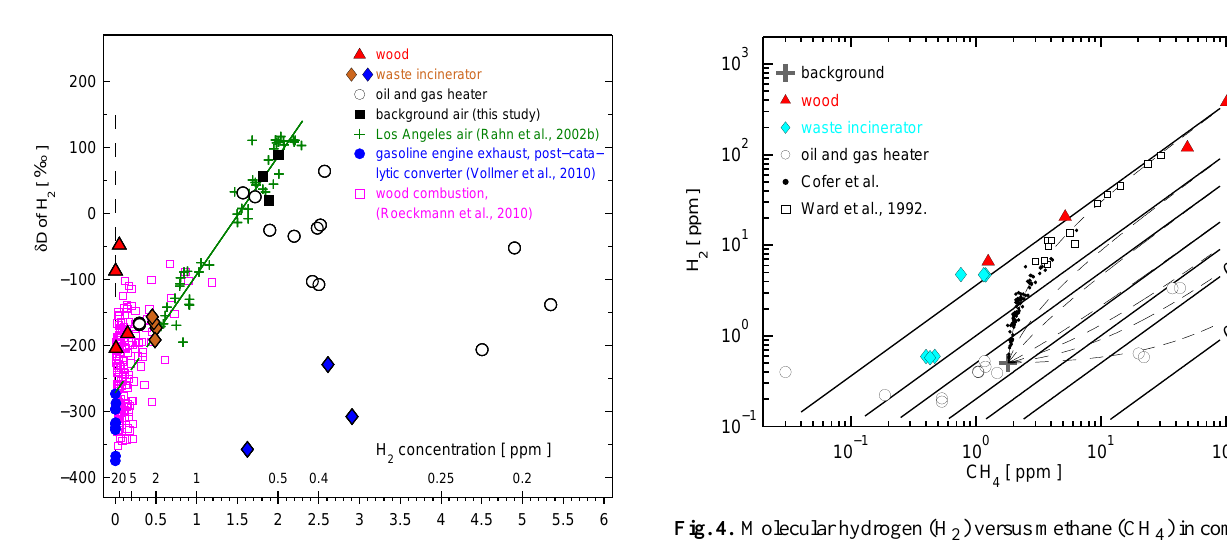
Fig. 4. Molecular hydrogen (H 2 ) versus methane (CH 4 ) in combus- tion exhaust. The measurements are shown on a log-log scale. Re- sults from wildfires are from Cofer III et al. (1989, 1990, 1996) and Ward et al. (1992) and show a molar 1 H 2 / 1 CH 4 ratio (background mole fractions subtracted) of 3.6 (weight based ratio 0.45). The H 2 and CH 4 mole fractions in background air are shown as grey plus sign. Molar H 2 /CH 4 ratio lines are shown as visual guides with the origins set at background mole fractions ( 1 ratio, backgrounds sub- tracted, see text) shown as dashed lines and at zero mole fractions (absolute ratios, no background subtraction) as solid